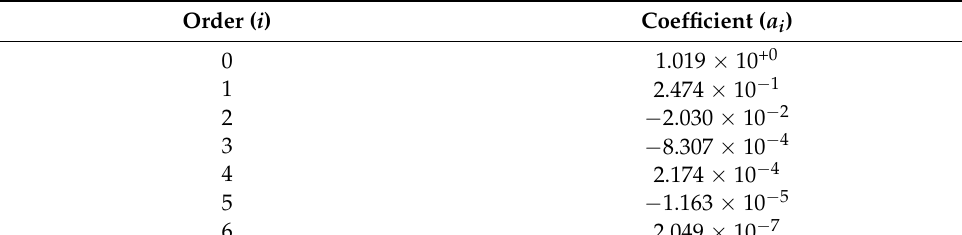
Table 4. Polynomial fitting coefficients.